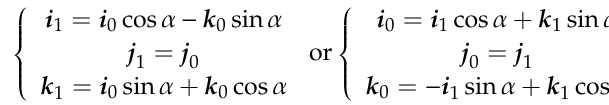
(cid:48) y (cid:48) z (cid:48) attached to the rigid with